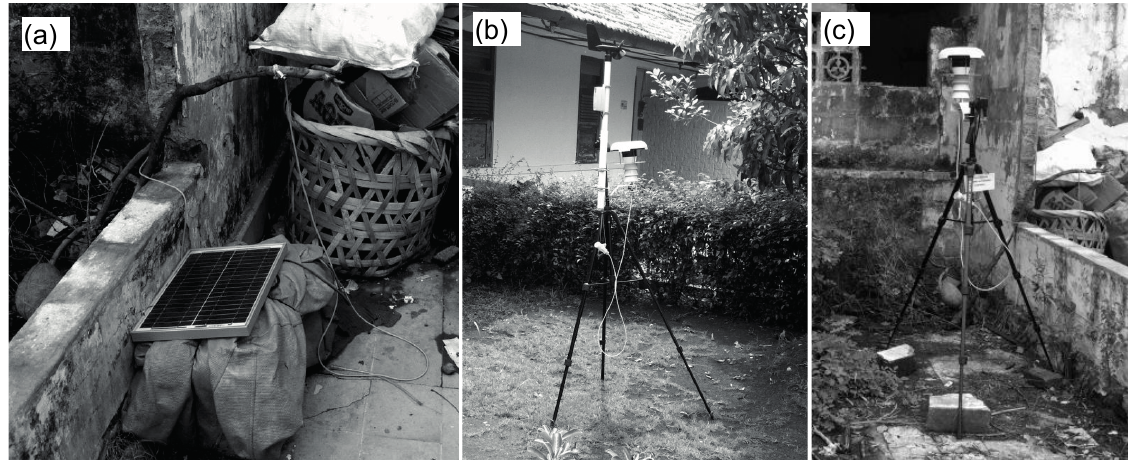
Fig. 1 Fixed-point observation equipment: (a) the infrared land surface thermometer, (b) the aerovane, and (c) the thermo-hygrometer.